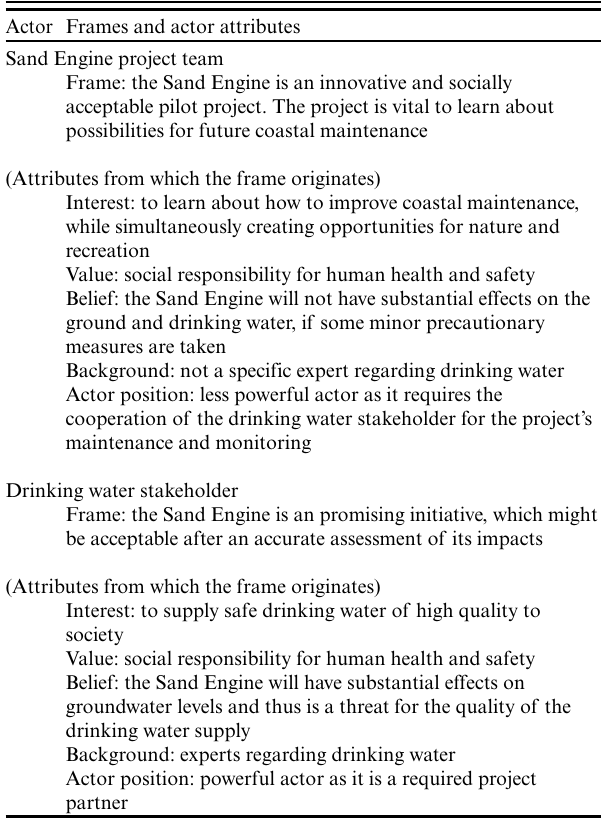
Table 4 . Sand Engine ambiguity 3: about the effects on groundwater level / drinking water